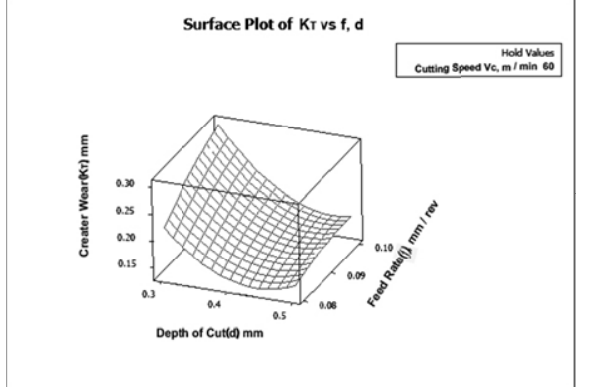
Figure 7. 3D Surface plot of K T vs. f and d .